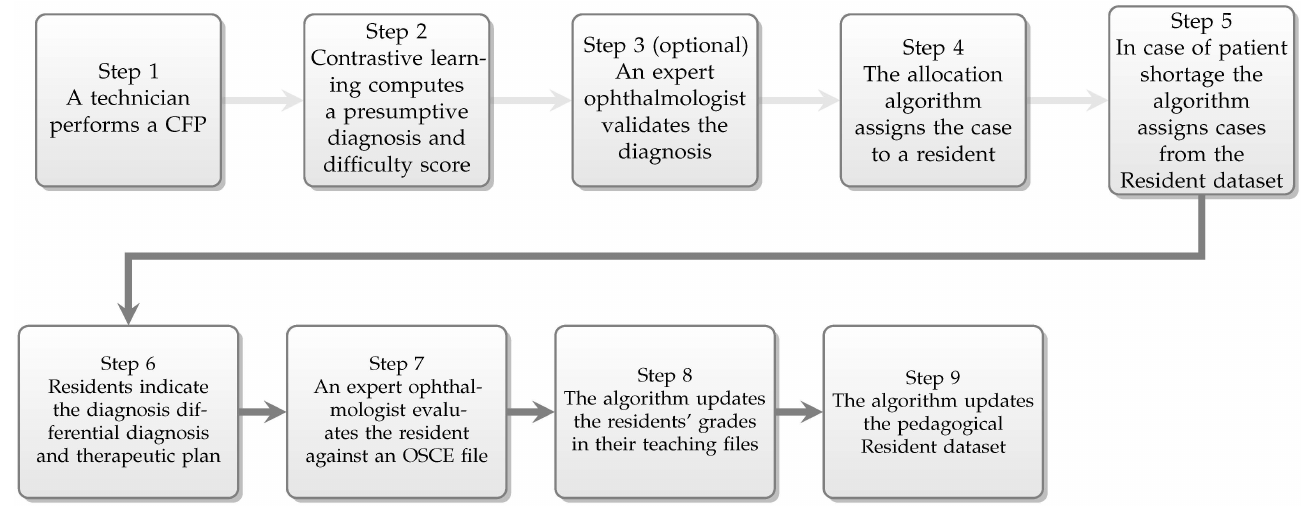
Figure 2. The assignment workflow.